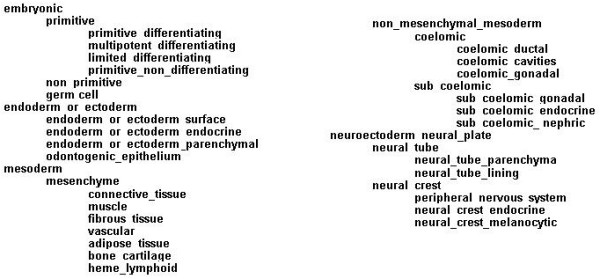
Developmental Lineage Classification Schema [2].